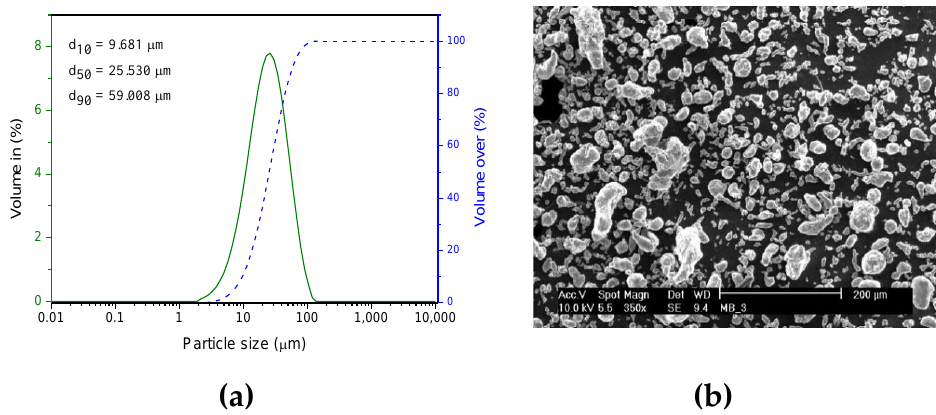
Figure 2. ( a ) Particle size of pure aluminium. ( b ) Scanning electron microscopy (SEM) images .